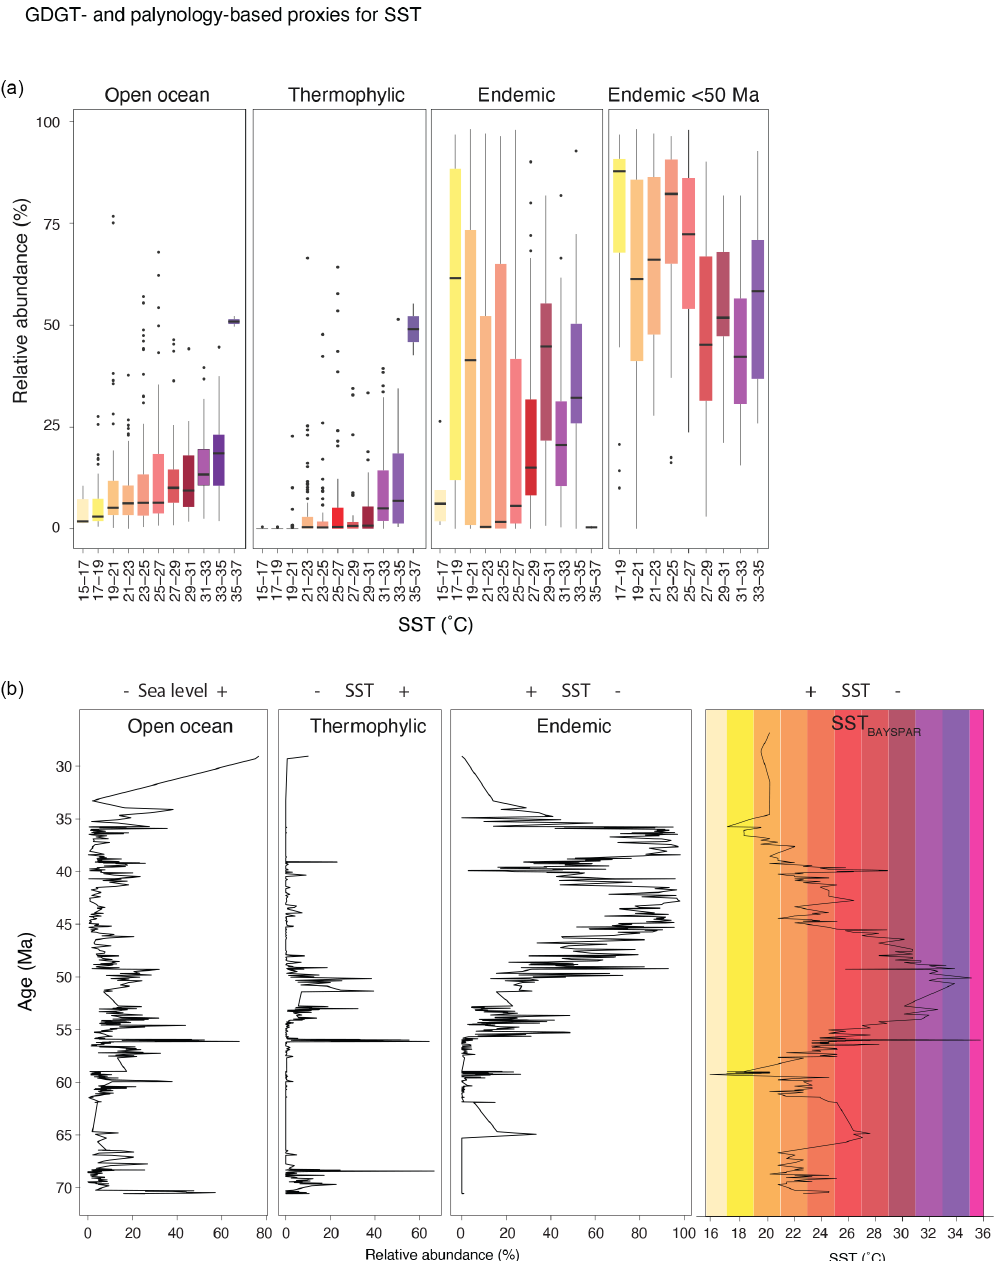
Figure 15. isoGDGT- and palynology-based proxies for SST. (a) Relative abundance of open-ocean, thermophylic and endemic-Antarctic dinocyst eco-groups (for groups, see Table 3; total dataset and samples < 50Ma only) plotted against linearly interpolated (resampled) TEX 86 -based SST, in 2 ◦ bins. Median (black bars), lower-to-upper quartiles (25th–75th percentiles; colored envelopes), lower-to-upper whiskers (95% confidence intervals; black lines), outlier samples (black dots). (b) Time series of the same dinocyst eco-groups and